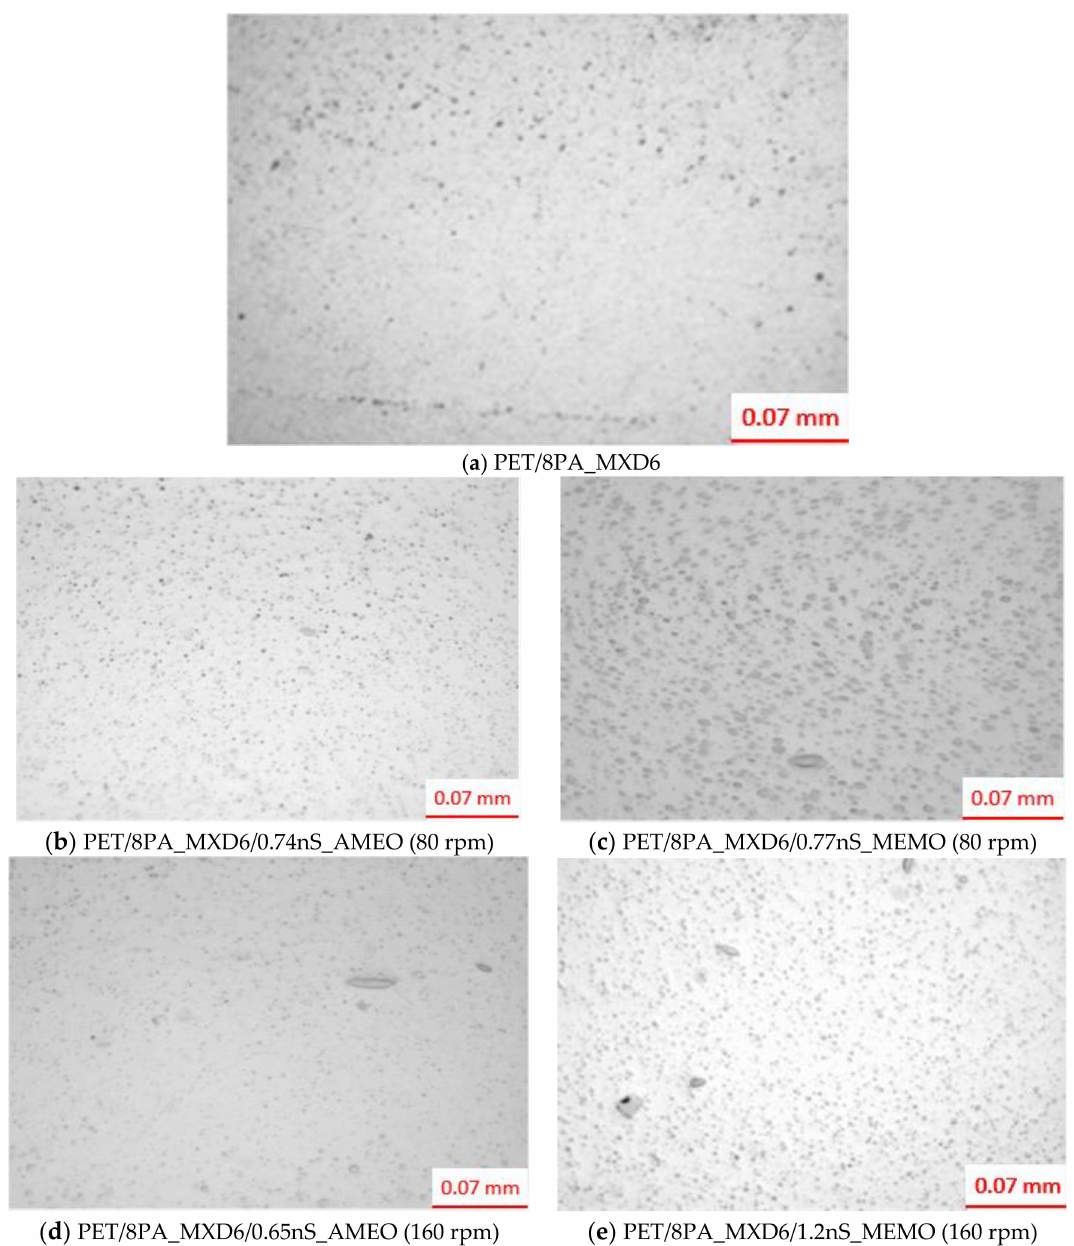
Figure 5. MO photomicrographs of nanocomposites PET/PA_MXD6/nS_AMEO and